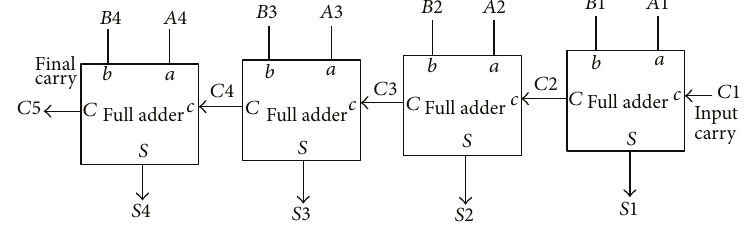
Figure 11: Block diagram of a 4-bit RCA.